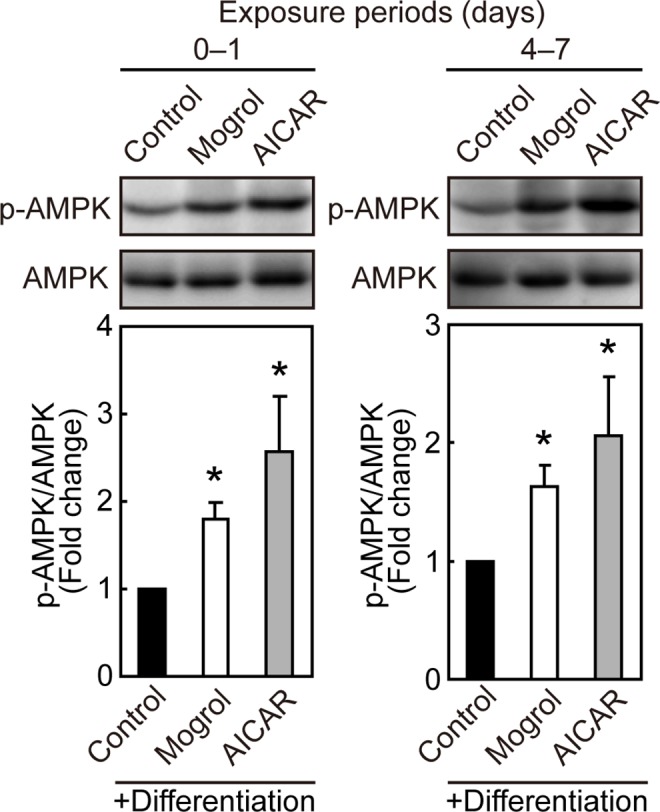
Effects of mogrol on the phosphorylation of AMP-activated protein kinase (AMPK).3T3-L1 cells were differentiated in the presence of mogrol (20 μM) from days 0–1 or from days 4–7, with cell lysates were prepared on days 1 and 7, respectively. The cell lysates were analyzed by Western blotting with anti-phosphorylated-AMPK (p-AMPK) or anti-AMPK antibodies. Data are representative of four independent experiments with similar results. The band intensity of phosphorylated AMPK was expressed relative to the band intensity of total AMPK. Error bars indicate the SD (n = 4); *p < 0.05 for the comparison with cells differentiated in the absence of mogrol (solid black bar), one way ANOVA with Dunnett’s post-hoc test.